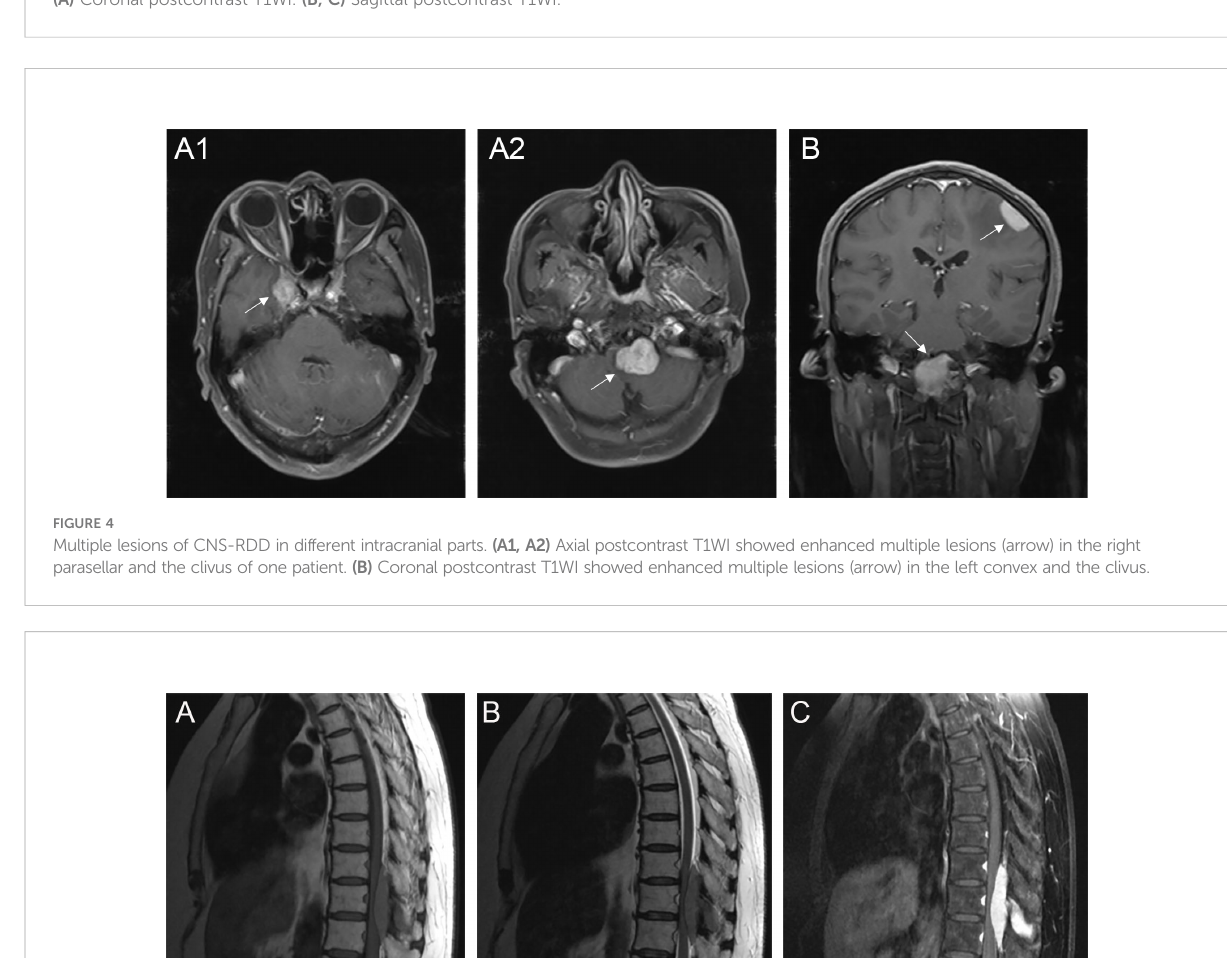
FIGURE 3 Postcontrast MRI images show that the irregularly thickened meningeal had a “ pseudopodium ” extending to the brain parenchyma (red arrow). (A) Coronal postcontrast T1WI. (B, C) Sagittal postcontrast T1WI.